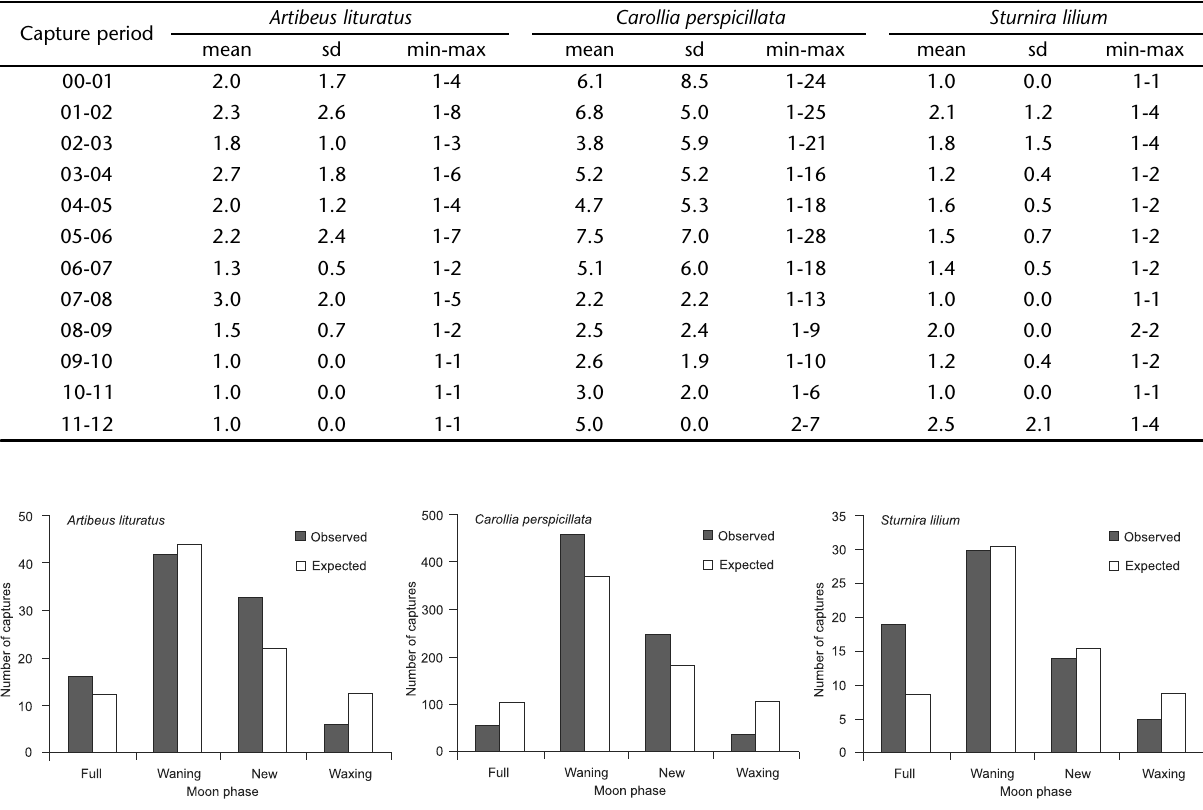
Figure 2. Variation in the number of captures of the bats Artibeus lituratus , Carollia perspicillata , and Sturnira lilium , in relation to moon phases, in the Poço das Antas Biological Reserve, southeastern Brazil. At this “among nights” scale, bats of all three studied species were captured more frequently on darker moon phases, even considering differences in sampling effort among moon phases.